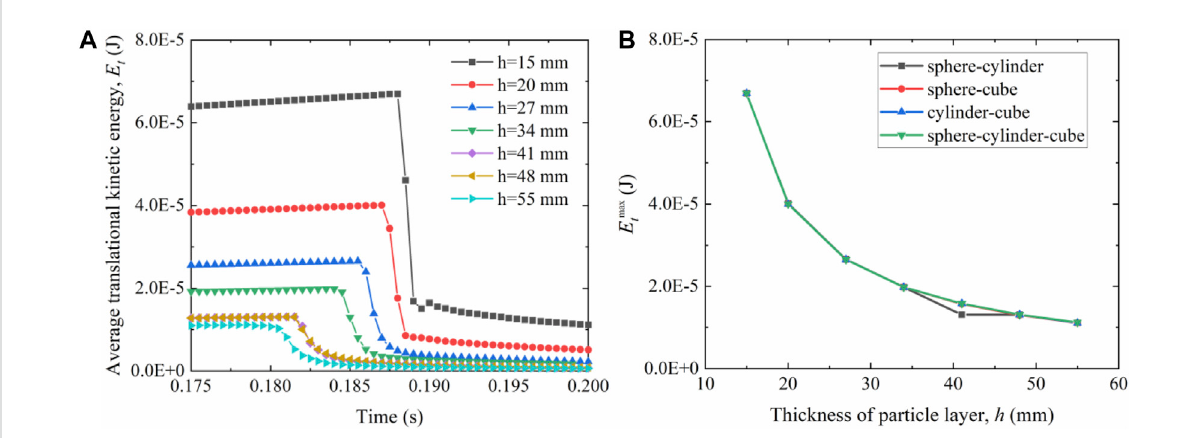
FIGURE 13 Evolution and comparison of the translational kinetic energy for the rockfall impacting against the granular material of buffering with different thickness of particle layer: (A) sphere-cylinder; (B) translational kinetic energy of max.